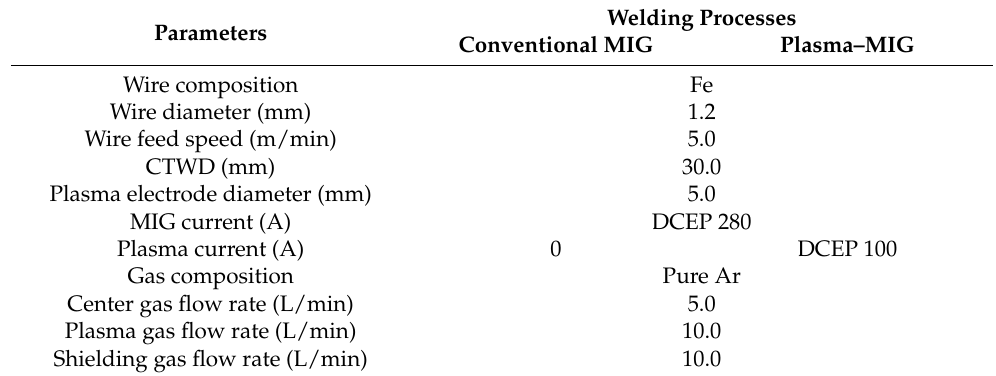
Table 1. Simulation